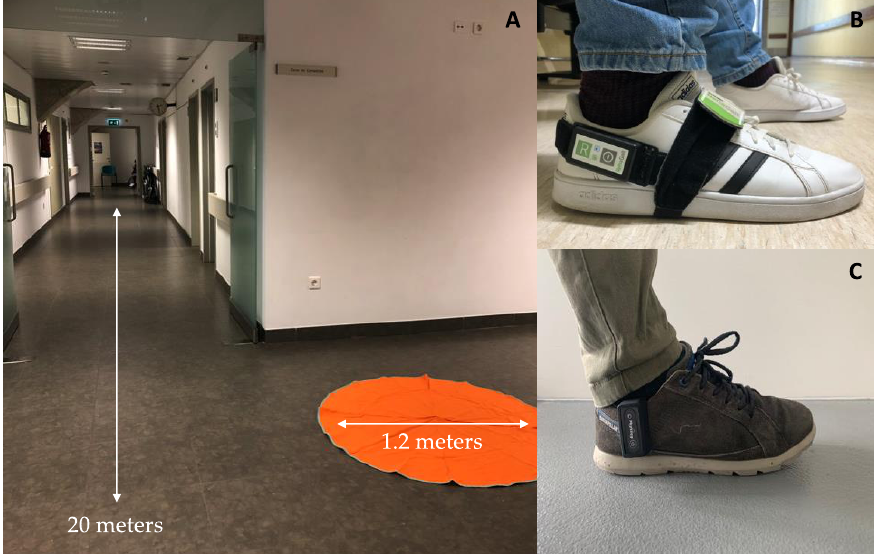
Figure 1. ( A ) Lab setting for the supervised assessment: 20 m walking and circular walking tasks. ( B ). Sensor positioning for lab assessment. ( C ). Sensor positioning for unsupervised assessment. During the second day of assessment, participants wore a Physilog ® 5 IMU (Gait Up, Lausanne, Switzerland) on the right foot between 9:00 and 9:30 a.m. (Figure 1). The device comprises a triaxial accelerometer and gyroscope with a sampling frequency of 128 Hz.